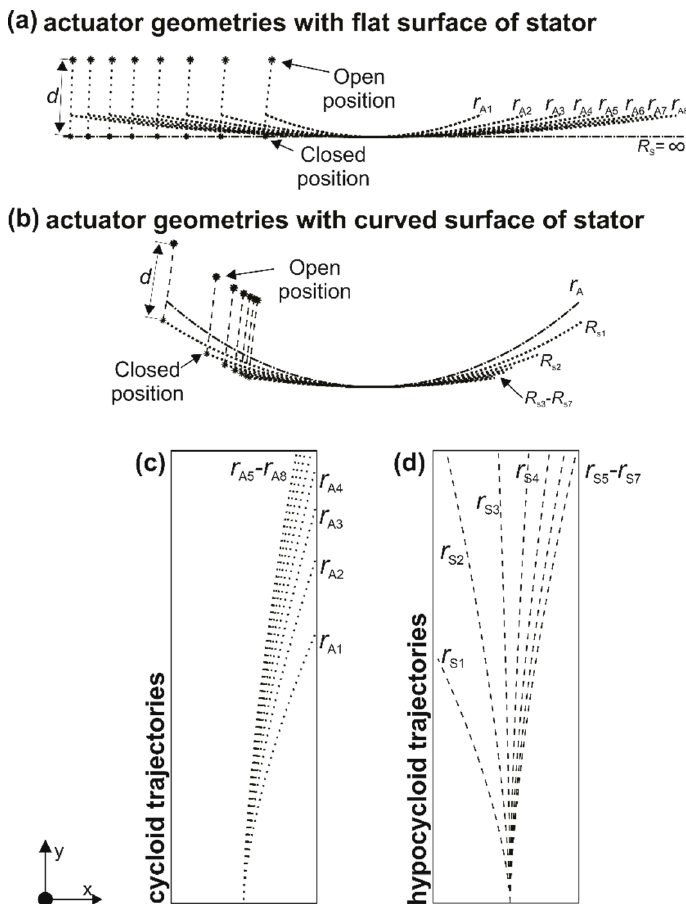
Figure 3. Comparison of different actuator rolling surface geometries at the same scale resulting in the same actuator displacement/stroke: ( a ) actuators with different mover radii r A rolling on flat stator surface ( R s = ∞ ); ( b ) actuators with different mover radii r A rolling on curved stator surface with different R s and ( c ) the comparison of cycloid (doted); and, ( d ) hypocycloid trajectories (dashed) obtained from same starting point due to different stator and mover radii.